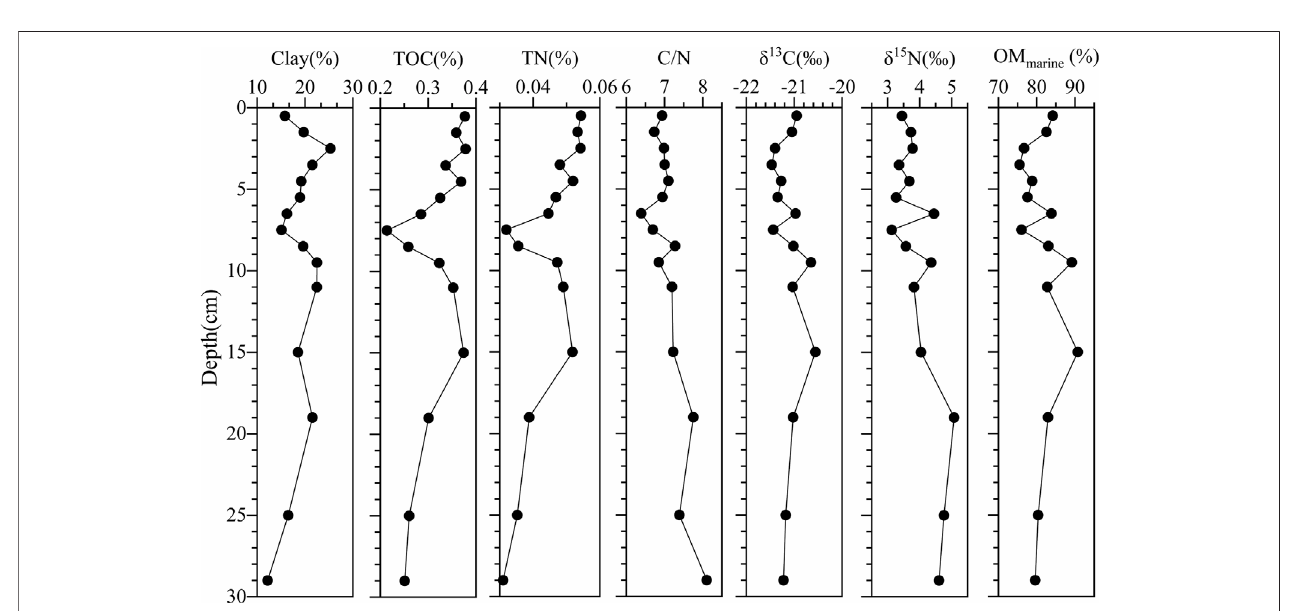
FIGURE 2 | Down-core variations of clay (%), TOC, TN, C/N, δ 13 C, δ 15 N, and proportion of marine organic matter (OM marine ) in core 3,050 –